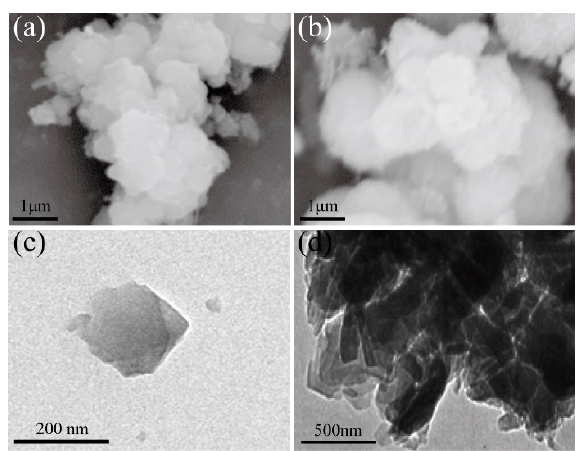
Figure 5. SEM and TEM images of ( a , c ) NH 2 -MIL-101(Al) and ( b , d ) IL@NH 2 -MIL-101(Al).